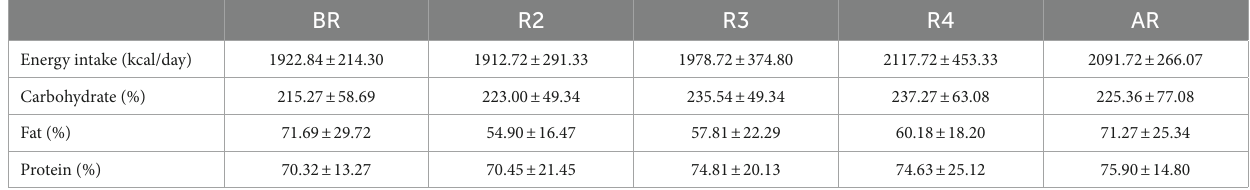
TABLE 2 Mean values ± standard deviation (SD) of estimated daily dietary intake recorded 1 week before Ramadan (BR), in the 2nd week of Ramadan (R2), in the 3rd week of Ramadan (R3), in the 4th week of Ramadan (R4), and 2 weeks after Ramadan (AR; n =